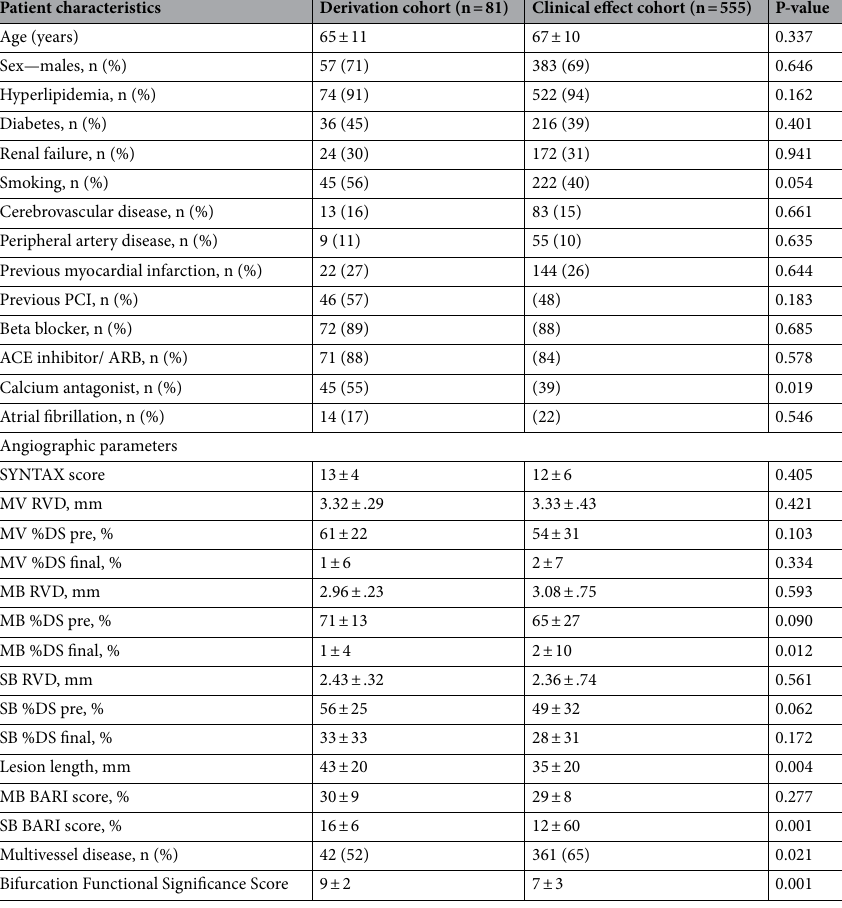
Table 4. Demographic and angiography characteristics of patients in derivation and clinical effect